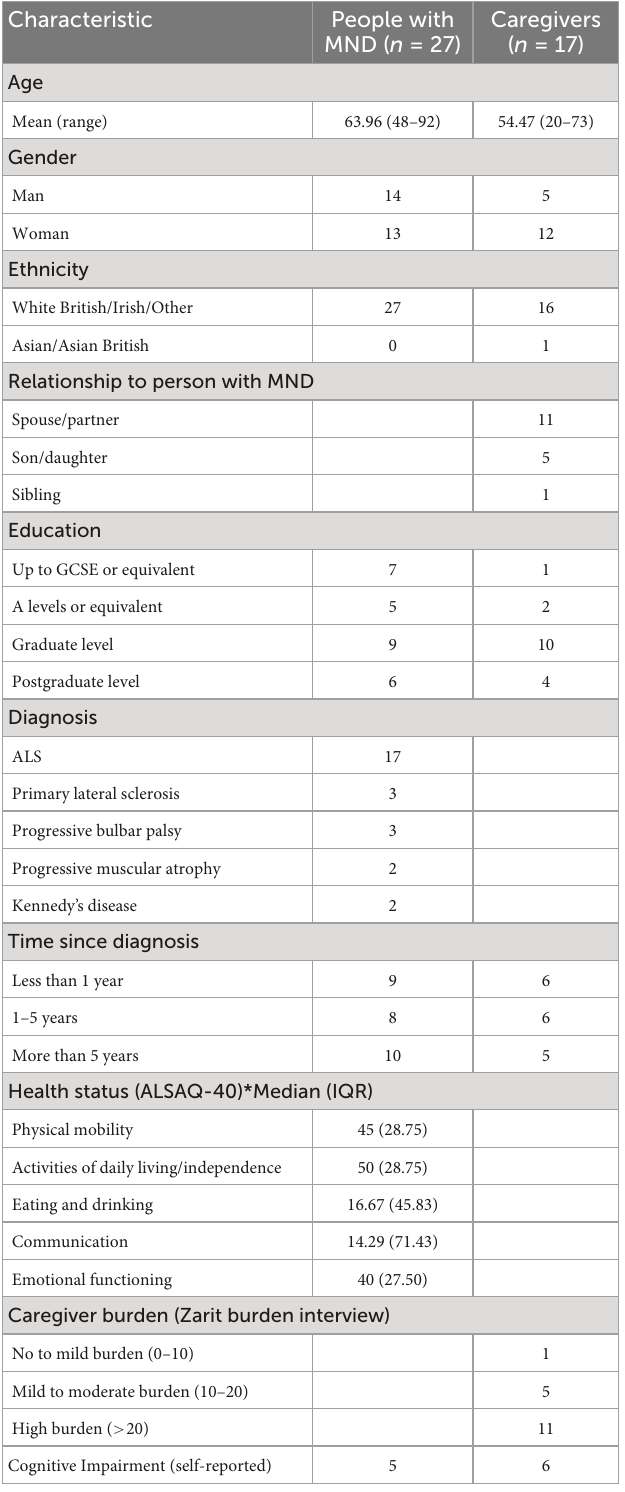
TABLE 1 Demographic and clinical details of the